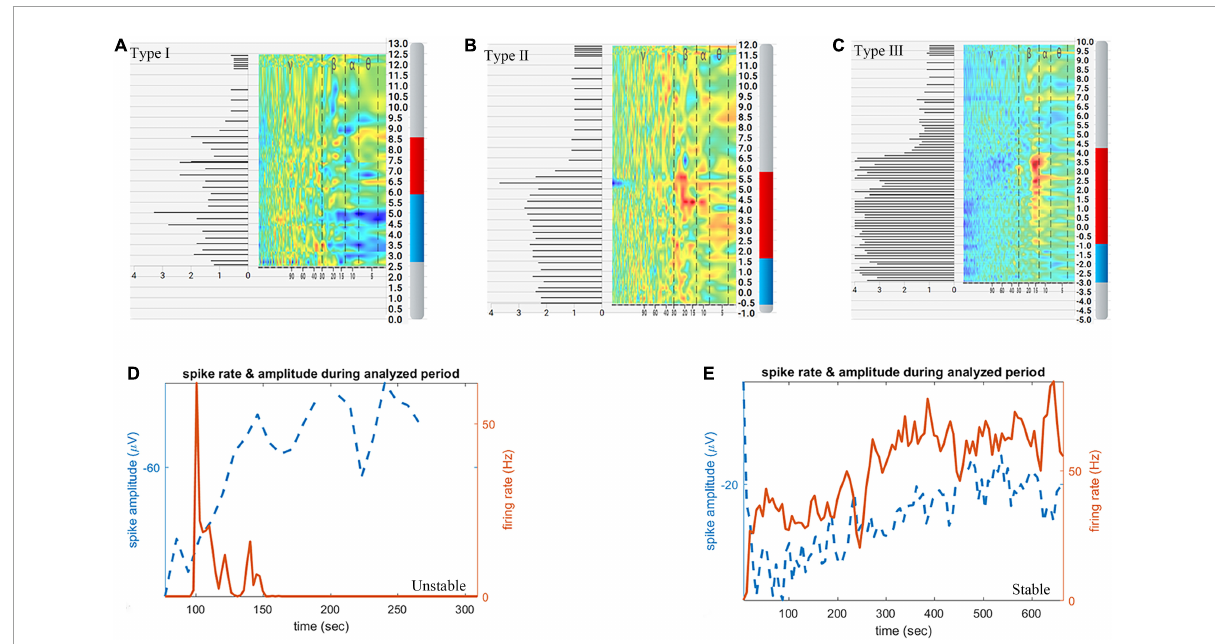
FIGURE2 Schematic diagram of subthalamic nucleus (STN) length, length of the sensorimotor area, classification of normalized root mean square (NRMS) and microelectrode recordings (MERs) stability. (A) Type I NRMS. (B) Type II NRMS. (C) Type III NRMS. (D) Unstable MERs. (E) Stable MERs. The red and blue bars in panels (A–C) indicate STN length, while the red bar in panels (A–C) indicates length of the sensorimotor area.